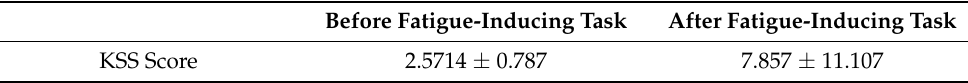
Table 3. Correctness and reaction time before and after fatigue-inducing tasks. Before Fatigue-Inducing